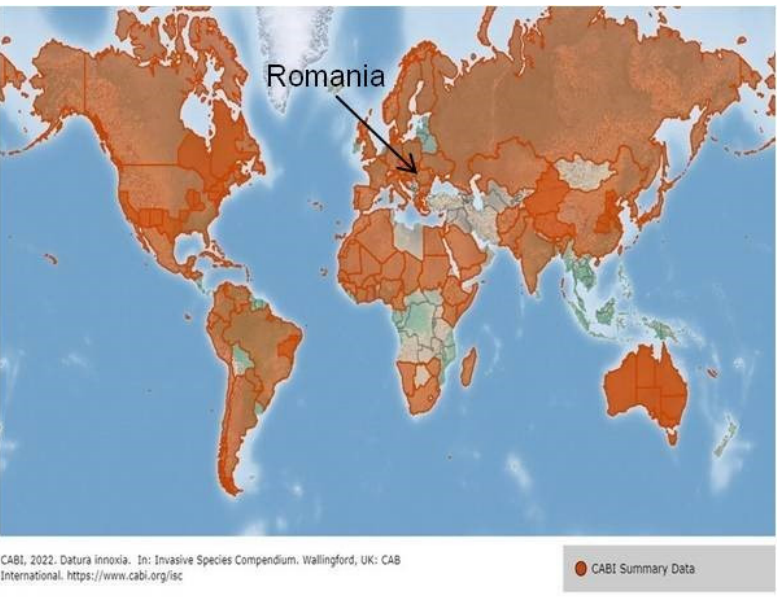
Figure 2. World map distribution of Daura innoxia [31].